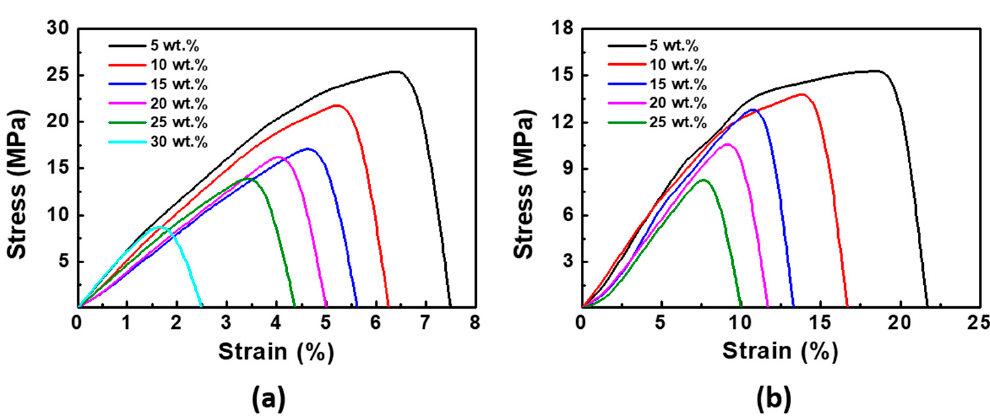
Figure 5. Tensile stress–strain curve of ( a ) fabricated filaments. ( b ) 3D-printed specimen. Table 2. Mechanical properties of the PCL/HA composite filaments and 3D-printed PCL/HA composite thin films. Filament Thin PCL/HA Composite